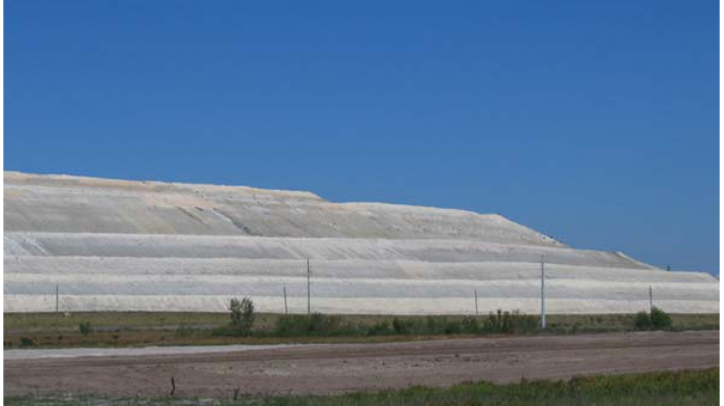
Figure 3. Phosphogypsum stockpile in Florida—byproduct from phosphate fertilizer production often considered too radioactive for reuse (Image from US Environmental Protection